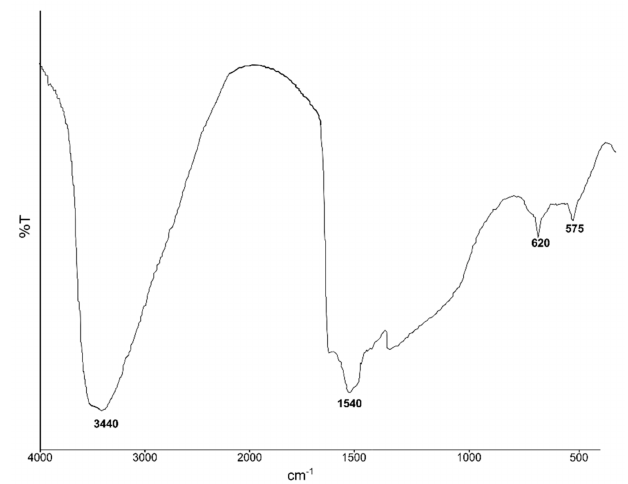
Figure 2. Fourier Transform Infrared (FTIR) spectra of